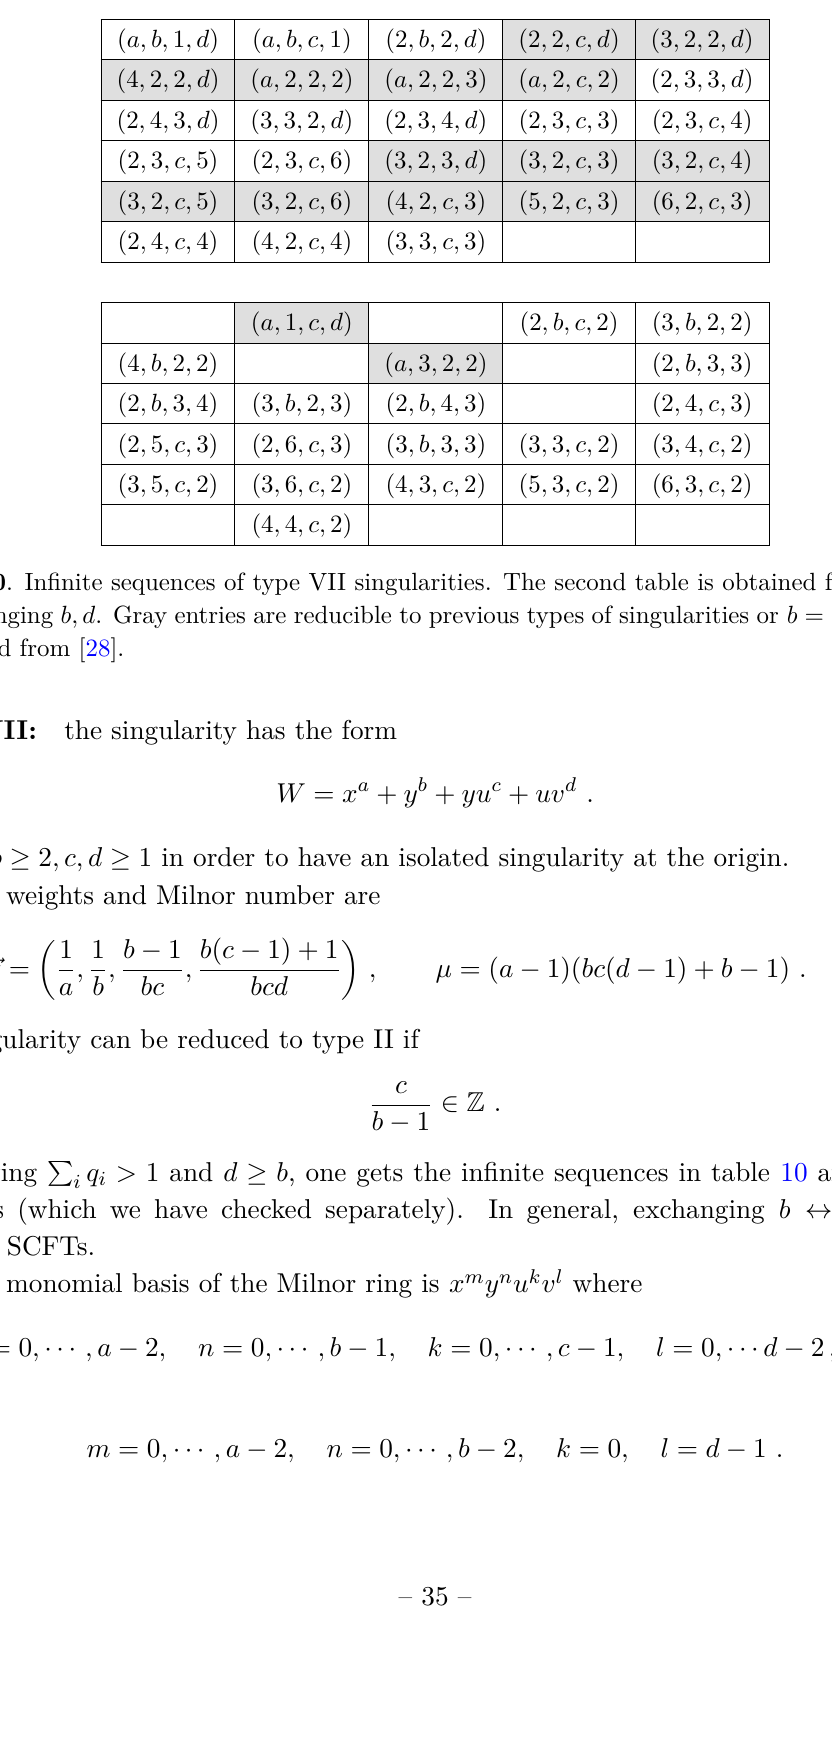
Table 9 . Infinite sequences of type VI singularities. Gray entries are reducible to previous types of singularities. This table is adapted from [28].